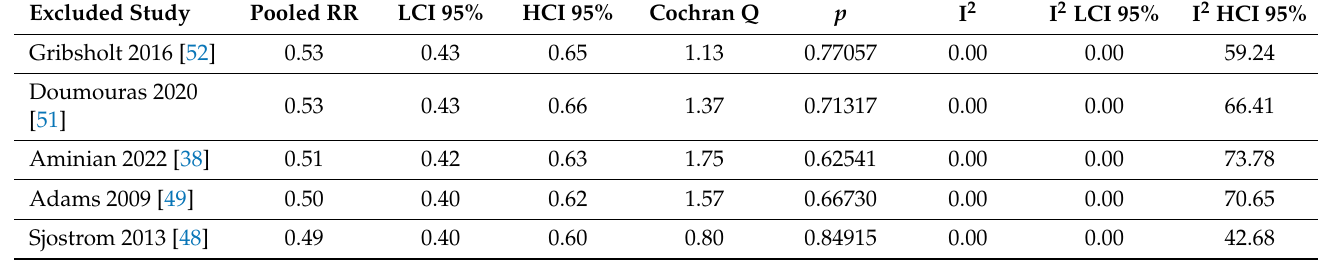
Table A3. Cancer-related mortality sensitivity analysis.